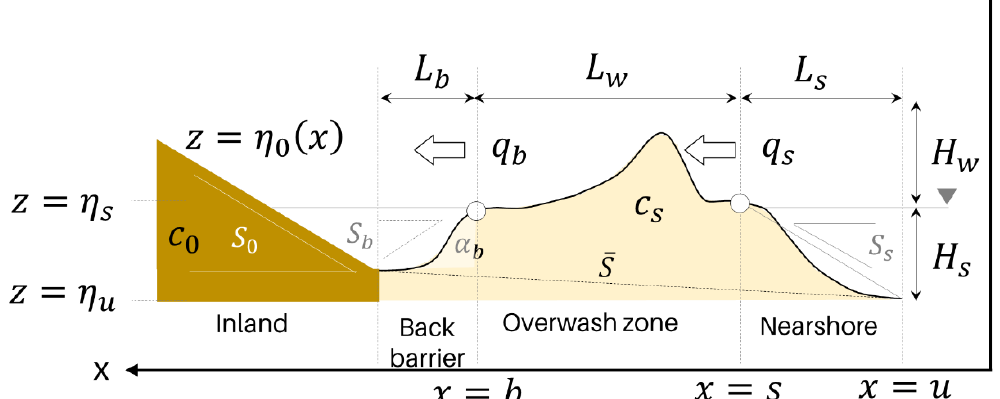
Figure 4. Idealized geometry and mass balance on a gentle coast. Barrier island consists of subaqueous shoreface, subaerial island (overwash zone) and subaqueous back-barrier. Island bounded seaward by shoreline s and landward by backshore b , both at sea level z sea . Shoreface and island have fixed geometry. Back-barrier slope S b and shape α b are fixed, but back-barrier length L b and relief H b can vary in time. Island maintained by overwash flux q s across the shoreline. Back-barrier growth fuelled by overwash flux q b across the backshore. Sand fraction c s of barrier island deposits may di ff er from sand fraction c 0 of backshore deposits. (Figure adapted by authors from